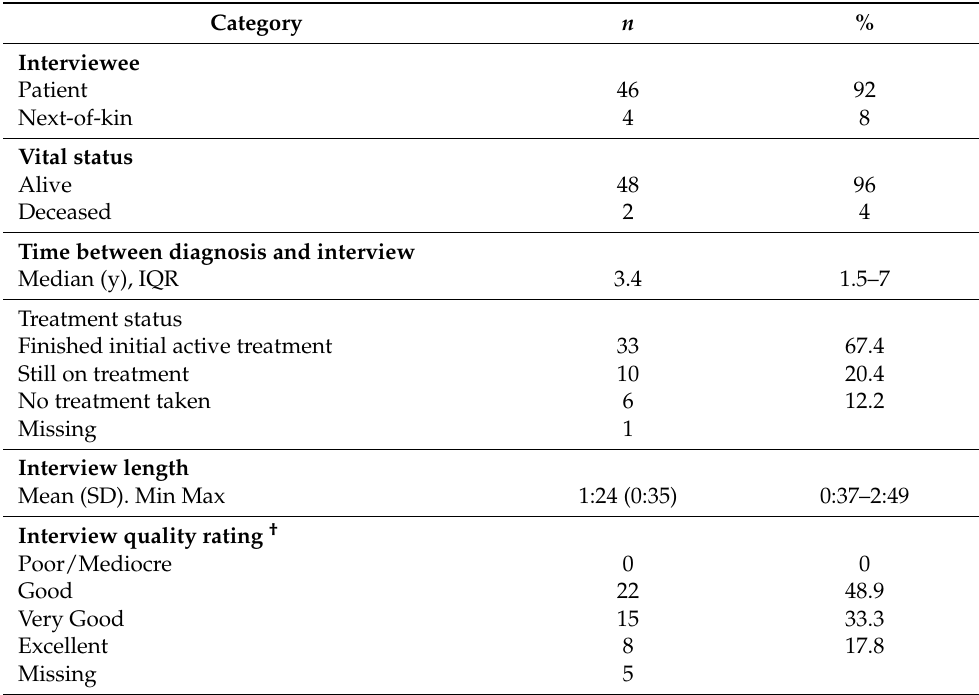
Table 2. Description of interview quality and